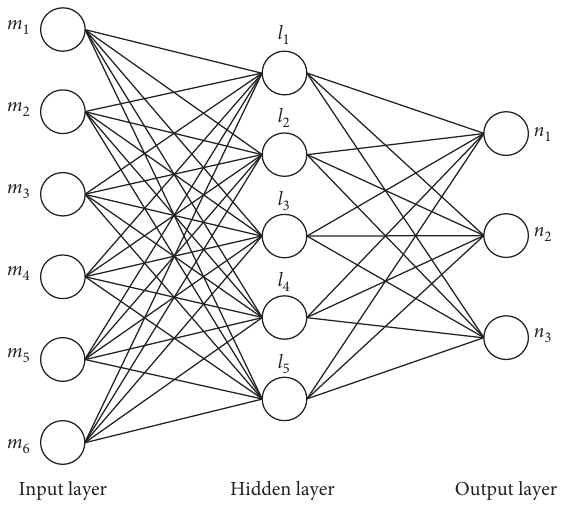
Figure 7: 3-layer BP neural network structure diagram. Table 5: Setting of BP neural network training parameters.